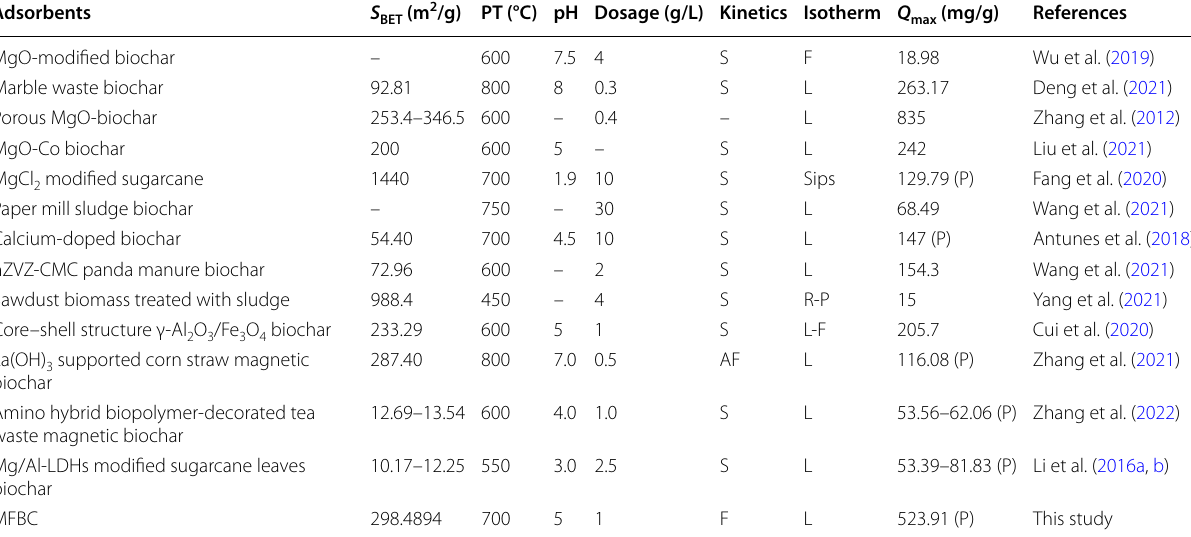
Table 3 Comparison between the maximum capturing capacities of some biochar adsorbents towards phosphate adsorptive removal